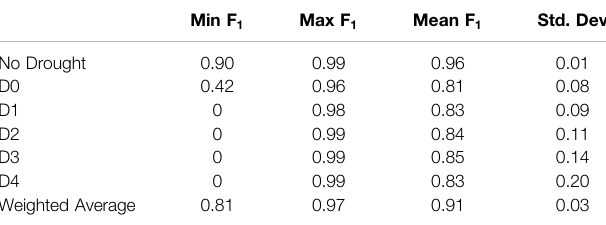
TABLE 3 | Persistence model descriptive statistics over the entire